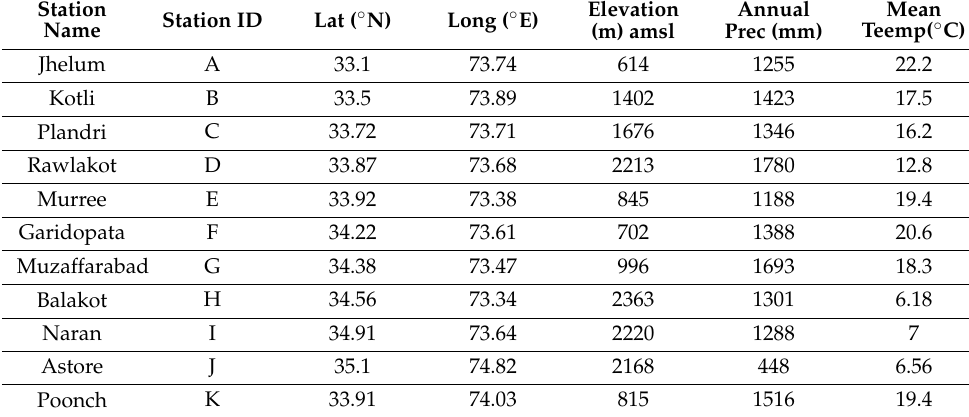
Table 1. Detail of the Meteorological